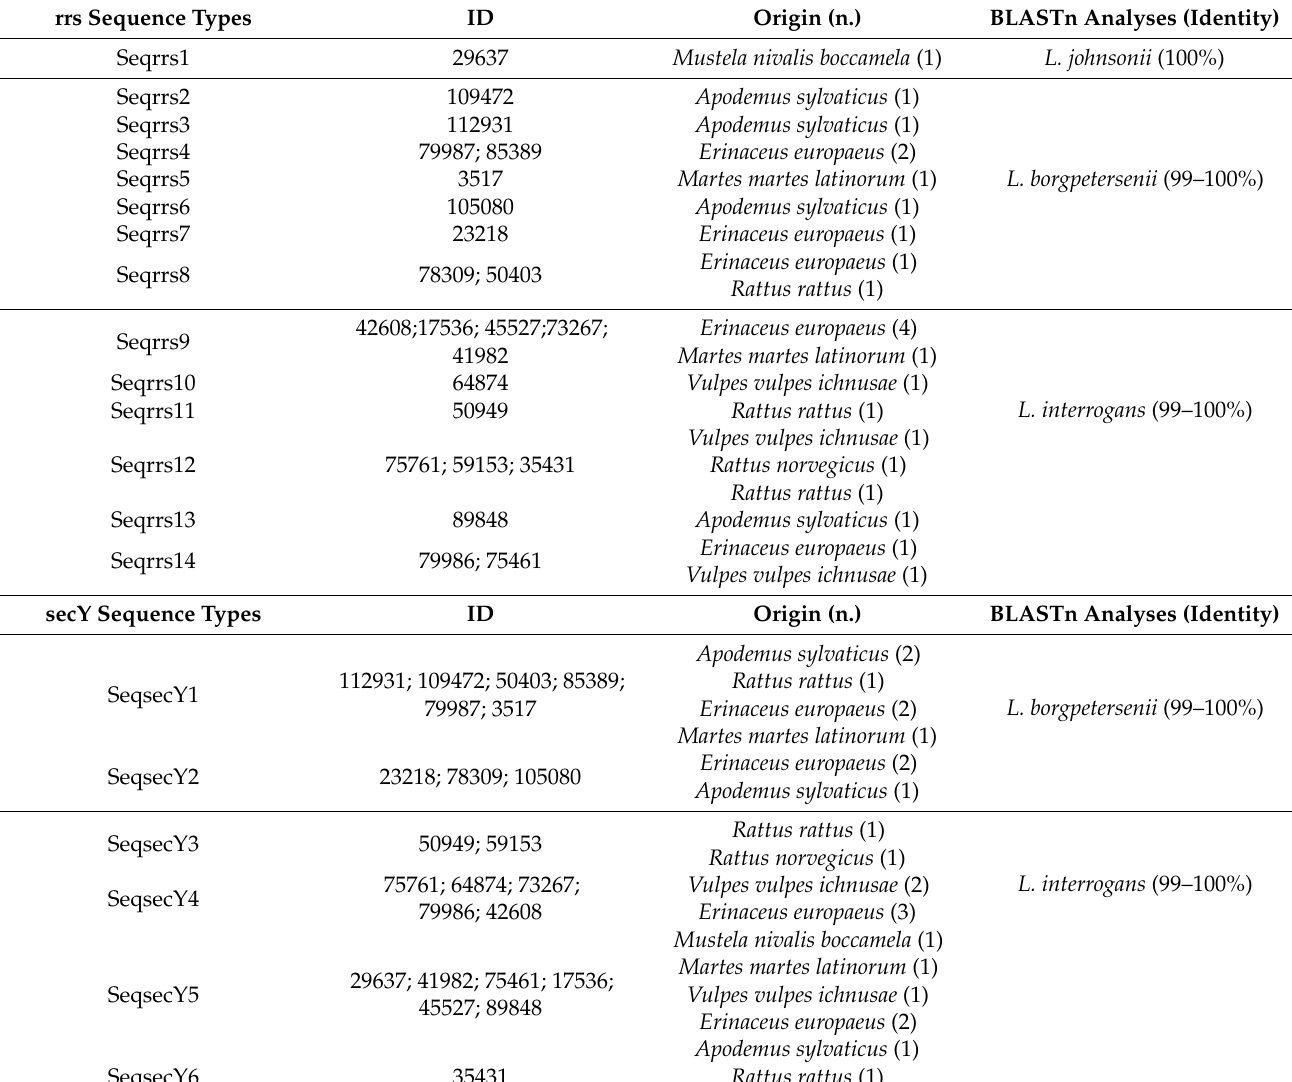
Table 3. Designation, sequence type, and maximum identities of the rrs and secY gene sequence types identified in this